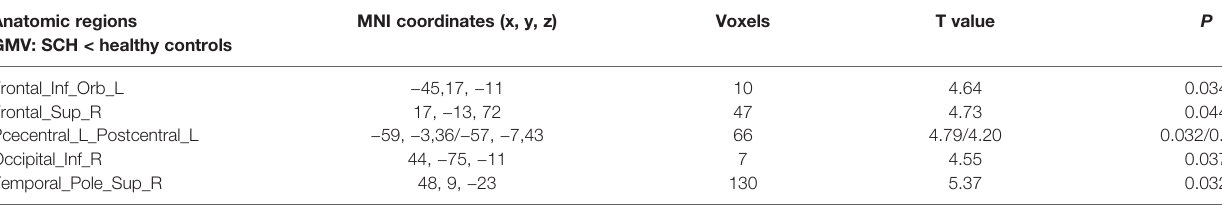
TABLE 2 | Gray matter volumes in SCH patients compared with healthy controls. Anatomic